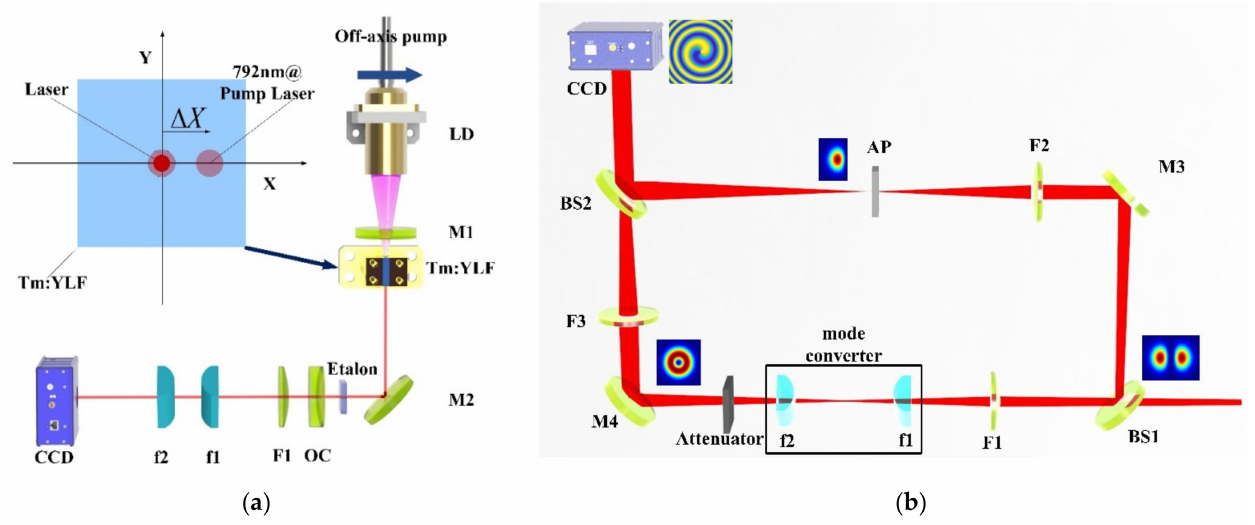
Figure 1. ( a ) Experimental setup of OAM- and wavelength-tunable 2 µ m vortex laser. ( b ) Experimen- tal setup of the Mach–Zeder interference